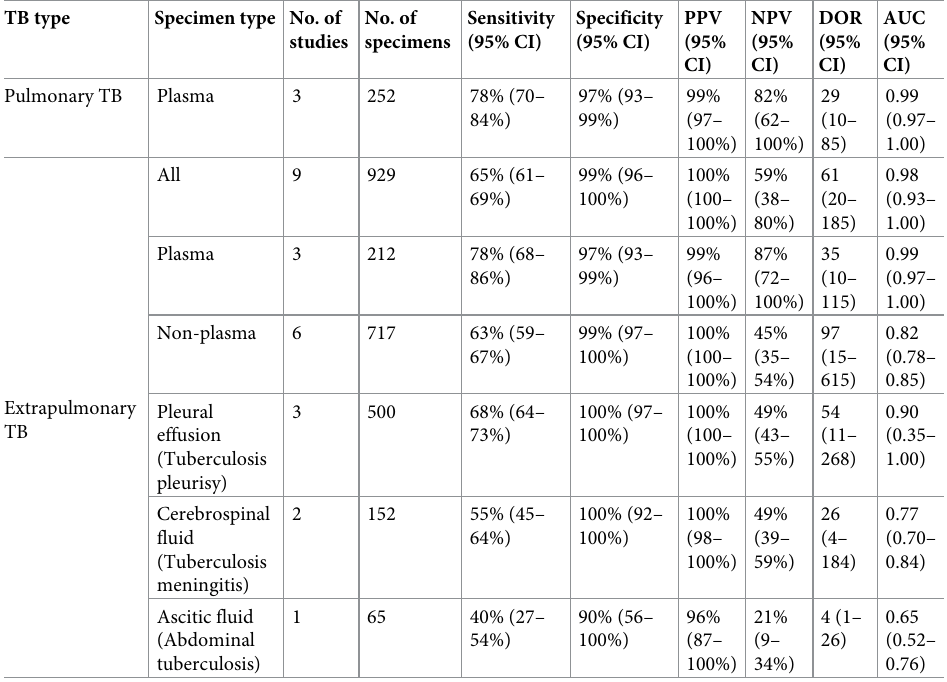
TB, tuberculosis; PPV, positive predictive value; NPV, negative predictive value; DOR, diagnostic odds ratio, AUC, the area under the summary receiver operating characteristic